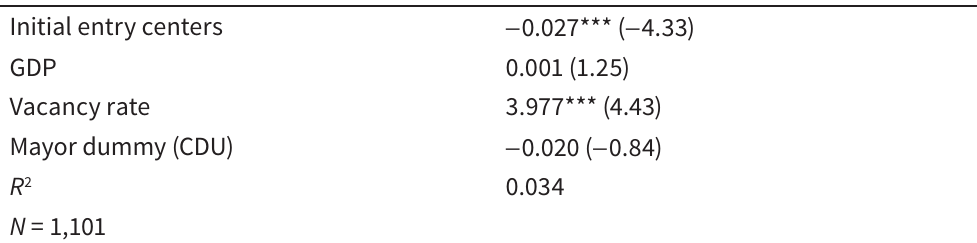
Determinants of refugee allocation Dependent variable: Refugee accommodations per 1,000